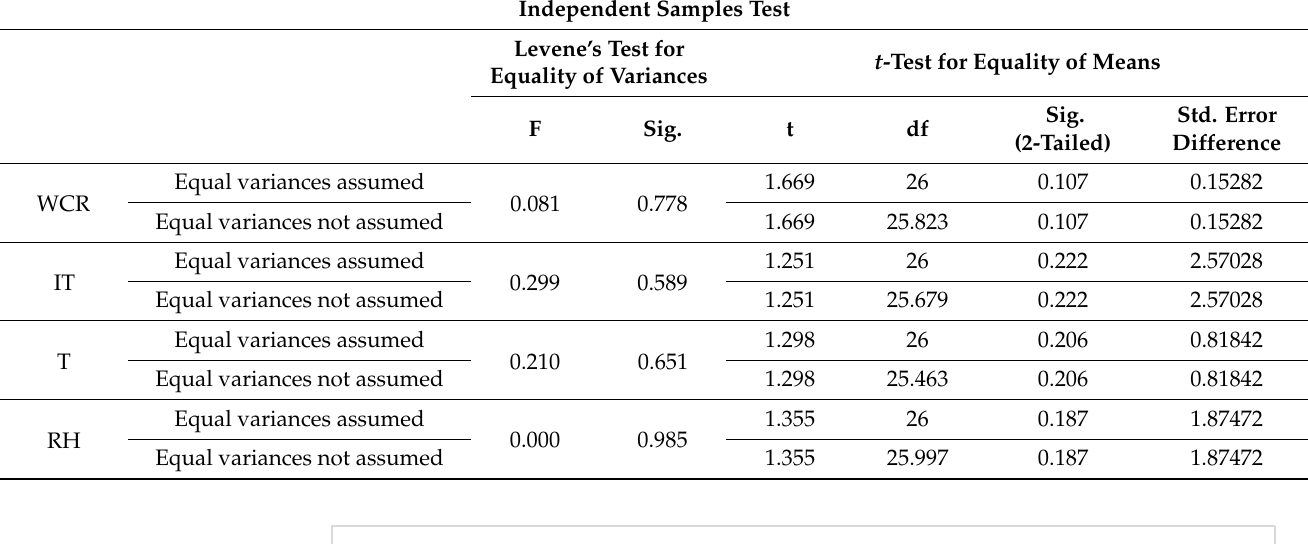
Table 3. T-test results of the independent samples for WCR, IT, T, and RH.